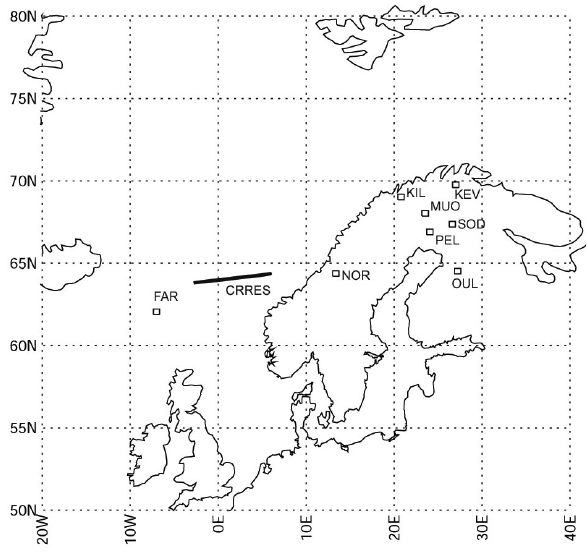
Fig. 1. Locations of ground-based magnetometers and the CRRES mapping to the ionosphere at 1-h interval, 20:00–21:00 UT, during the substorm on 12 March 1991.